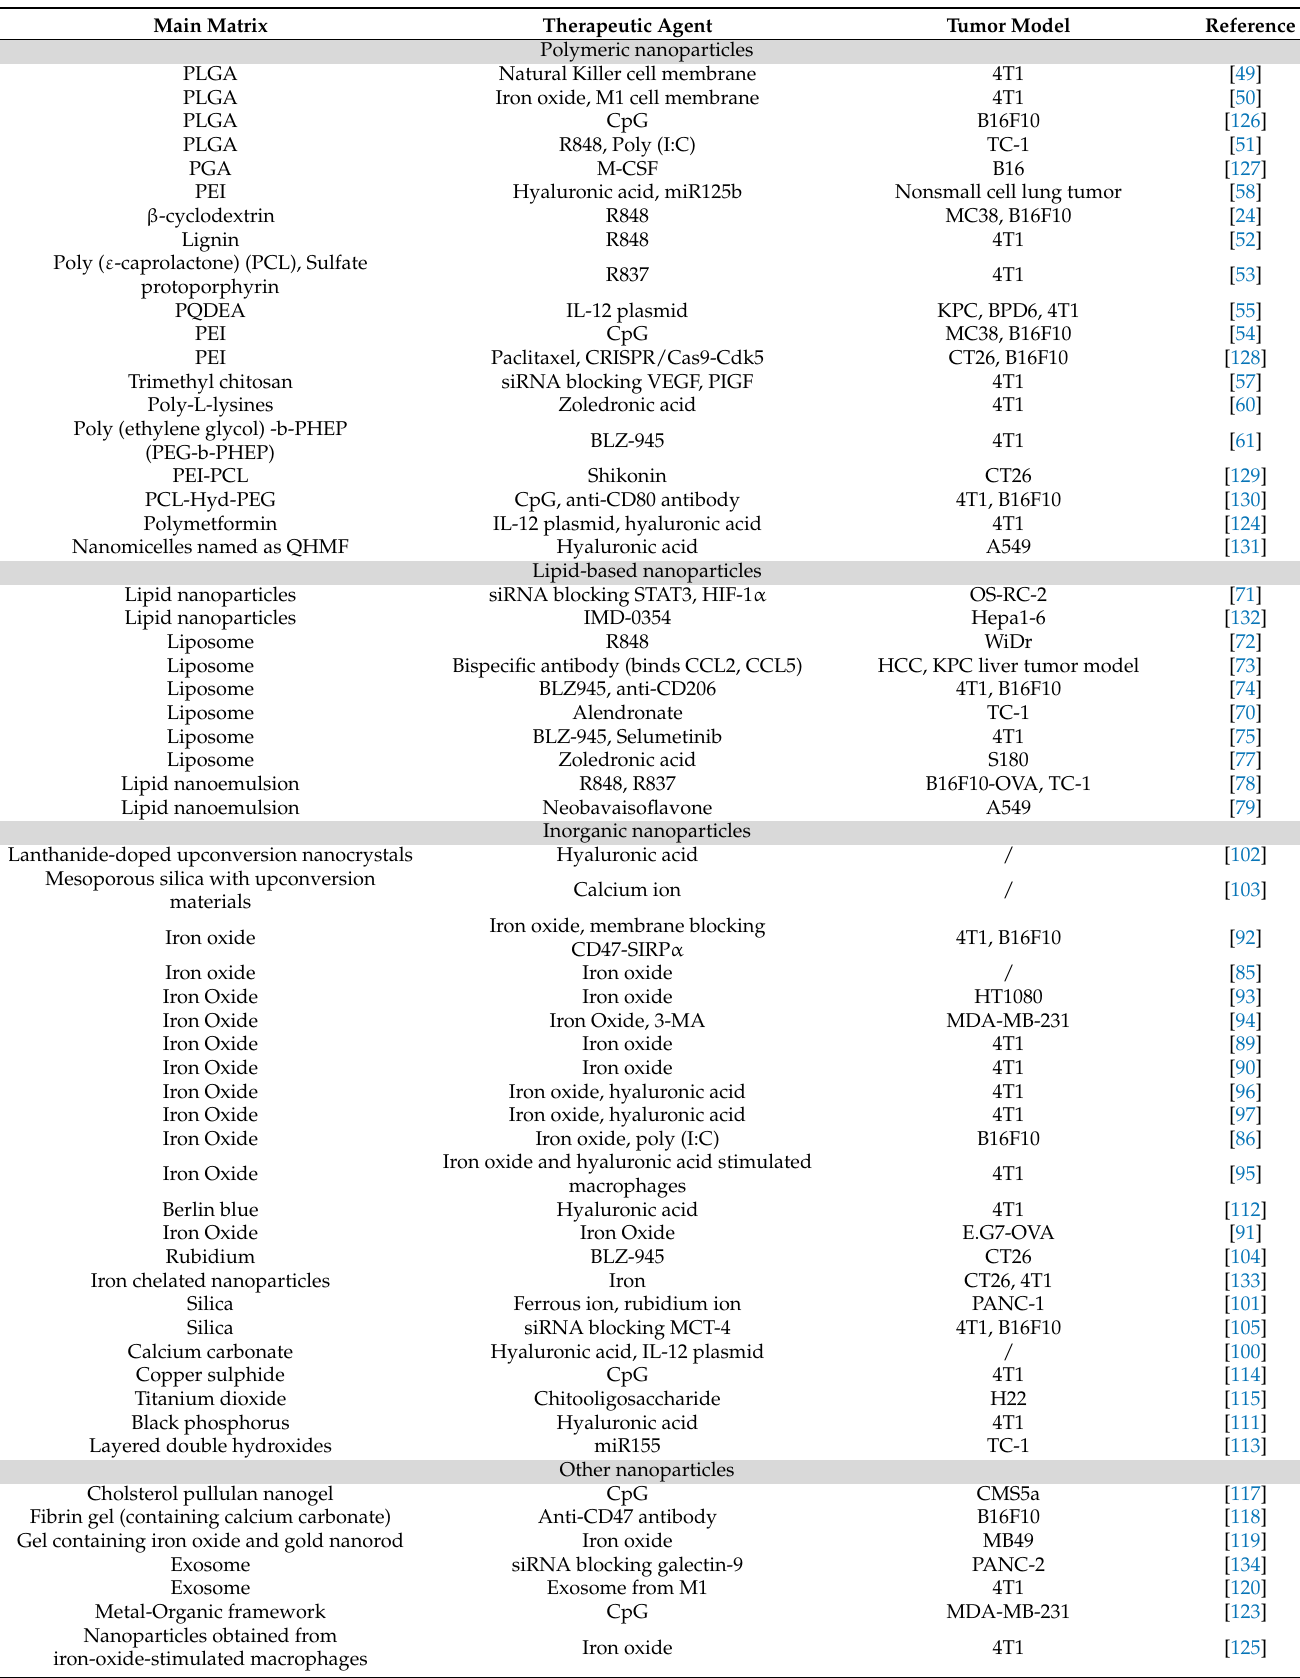
Table 1. Various nanostrategies targeting TAM